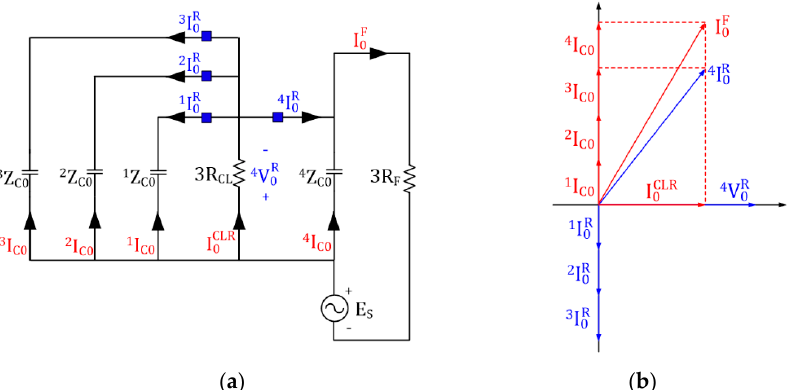
Figure 3. Simplified sequence network and corresponding phasor diagram in the case of an SLG fault in the fourth feeder: ( a ) simplified sequence network; ( b ) corresponding phasor diagram.